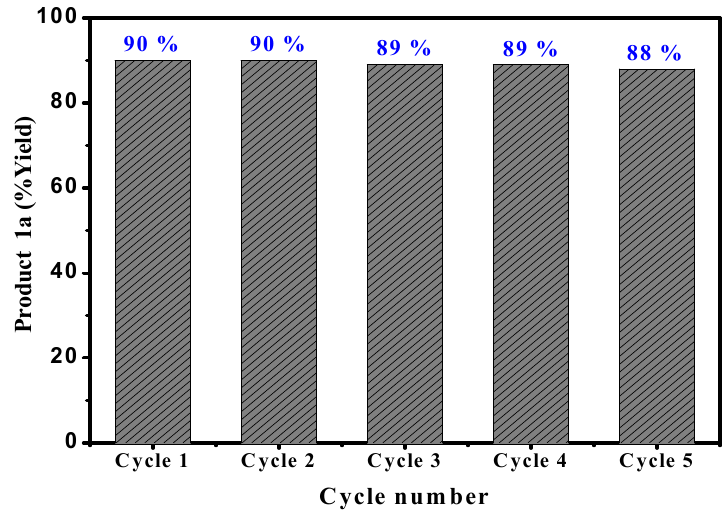
Figure 5. Recyclability of the CS-MgO film as a basic catalyst.